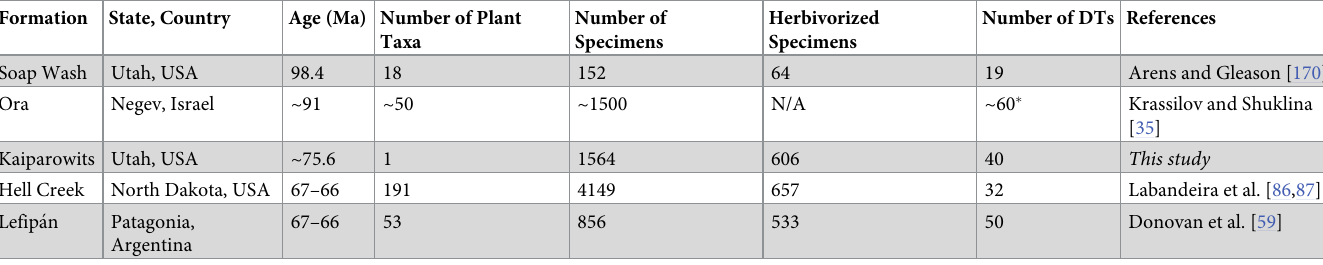
Table 3. Late Cretaceous floras analyzed for